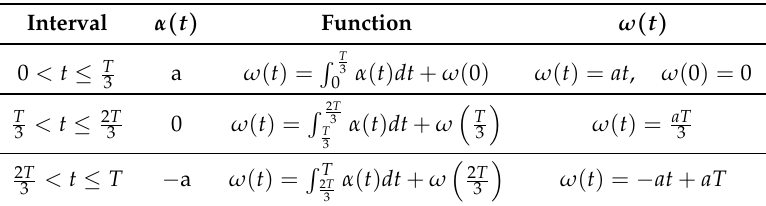
Table 3. Angular velocity for each acceleration interval.